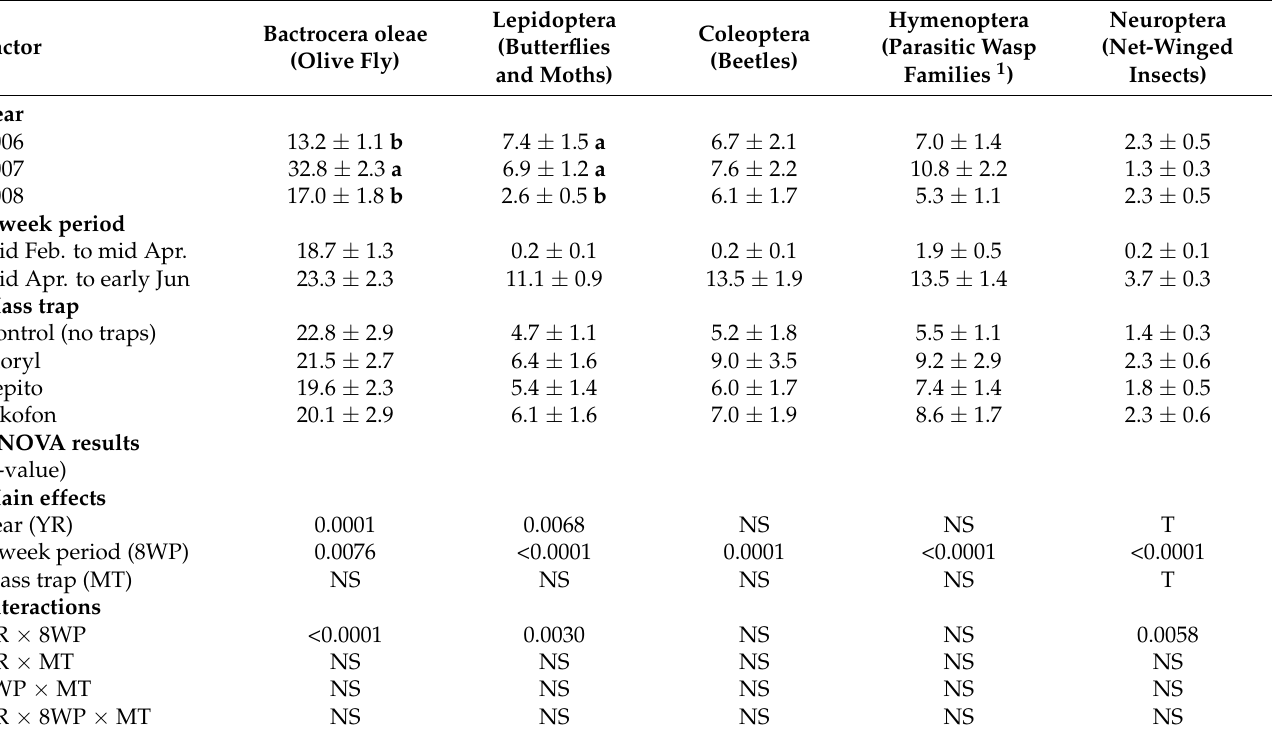
Table 5. Effect of, and interactions between, (a) year (2006, 2007, 2008), (b) 8-week period (mid- February to mid-April, mid-April to early-June), and (c) mass-trapping system on the activity (insects caught in McPhail monitoring traps) of major invertebrate groups/orders before mass-trapping systems were placed into table olive trees.